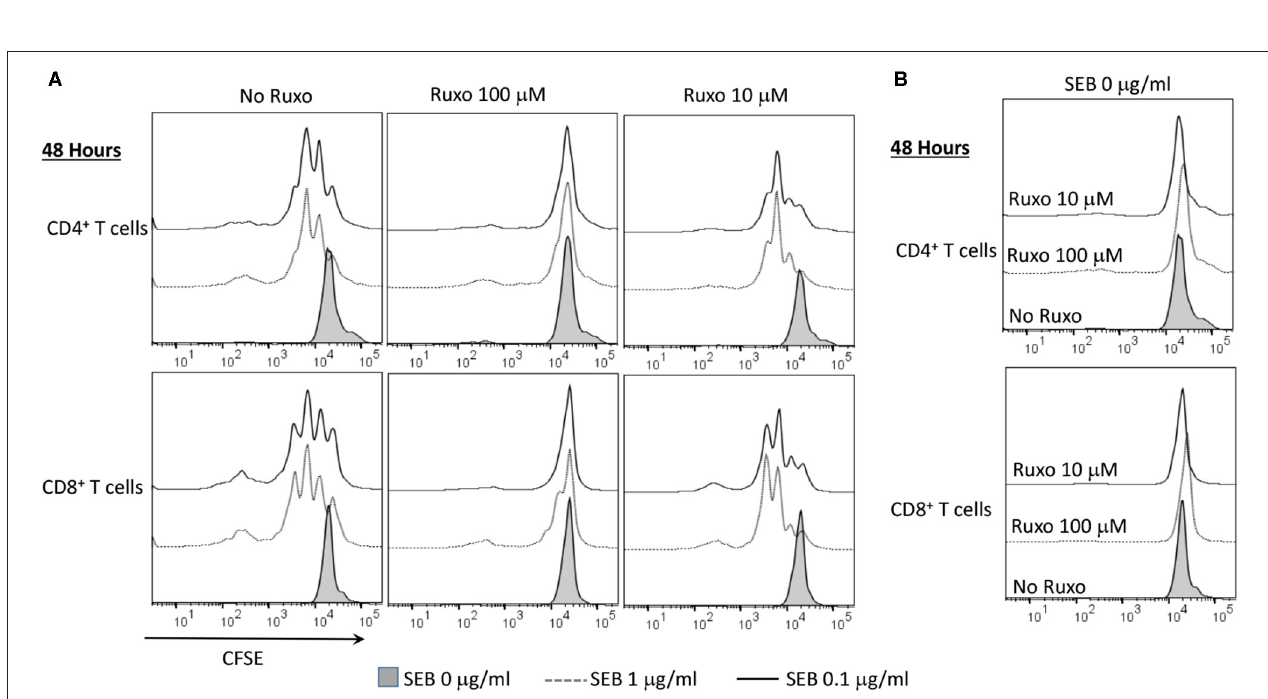
FIGURE 8 | Ruxolitinib inhibits superantigen-induced T cell proliferation in vitro . Splenic T lymphocytes were isolated from HLA-DR3 transgenic mice using a Miltenyi negative selection kit and labeled with CFSE as described in methods. The non-T cell fraction was eluted and used as antigen presenting cells (APCs). CFSE-labeled T cells were cultured with APCs in the presence of indicated concentrations SEB (A) or with medium alone (B) , in the presence of ruxolitinib or vehicle for 48h. After the incubation period, the cells were washed, stained with indicated antibodies and the extent of T cell proliferation was determined by flow cytometry. Similar results were obtained from 3 independent